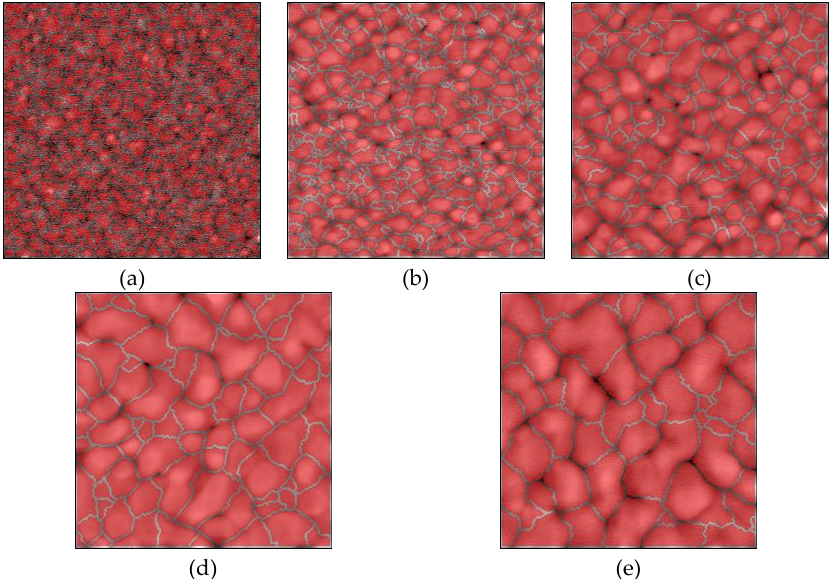
Figure 3. Typical AFM images of Au thin films deposited on Si wafers with grains segmented using the watershed algorithm: ( a )–( e ) films with thicknesses of 15, 50, 100, 300, and 500 nm, respectively.